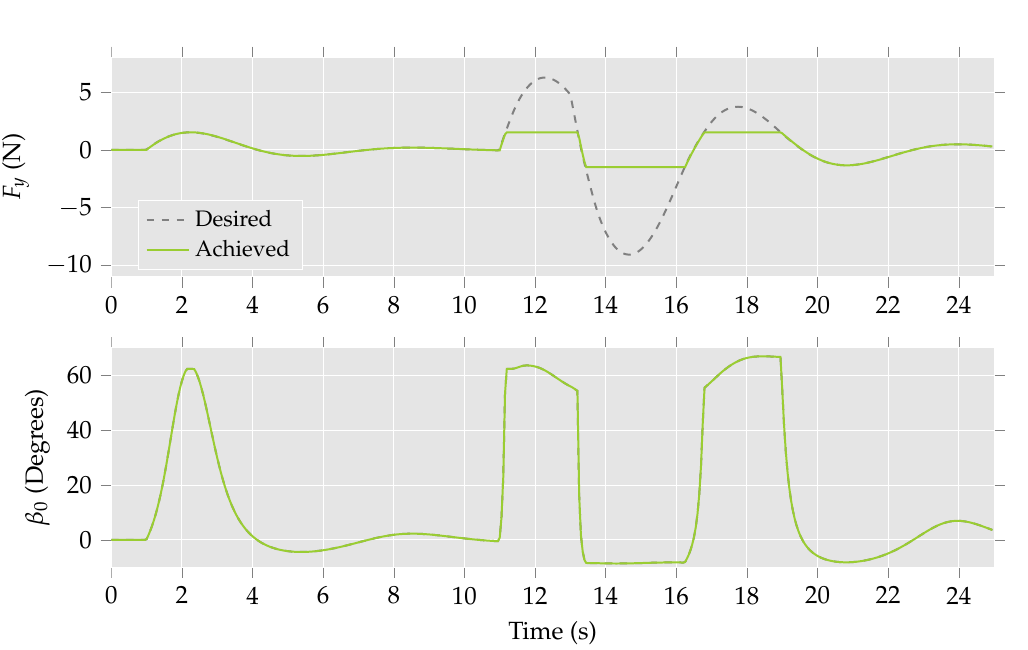
Figure 6. Multirotor helicopter attitude.